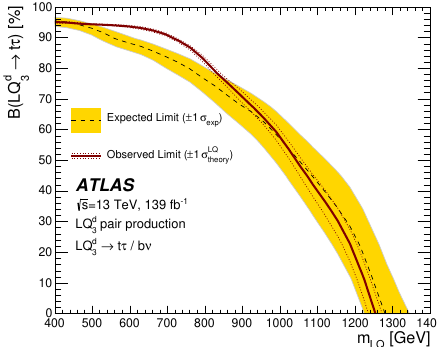
(cid:16) (cid:17) LQ d as a function of the LQ d → tτ 3